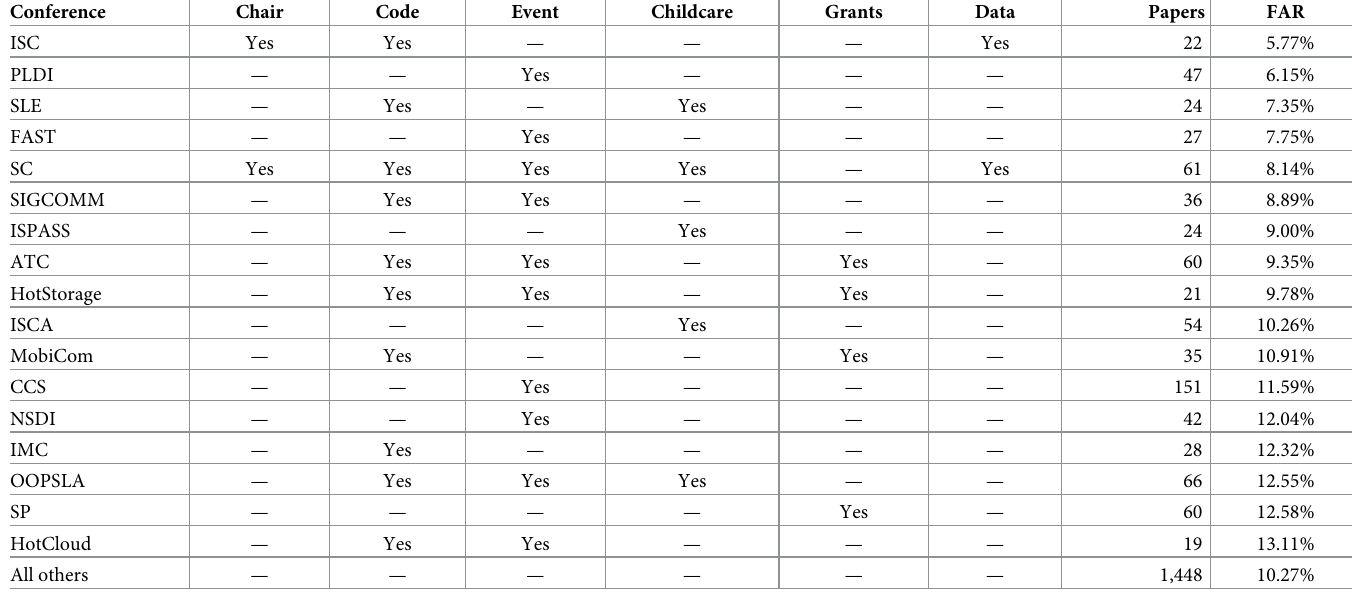
Table 4. Conferences with inclusivity initiatives, including diversity chair, code of conduct, special diversity events or workshops, assistance with childcare, travel grants for underrepresented minorities, and diversity data collection and publication. Conferences are ordered by increasing female author ratio (FAR). The last row summarizes the remaining